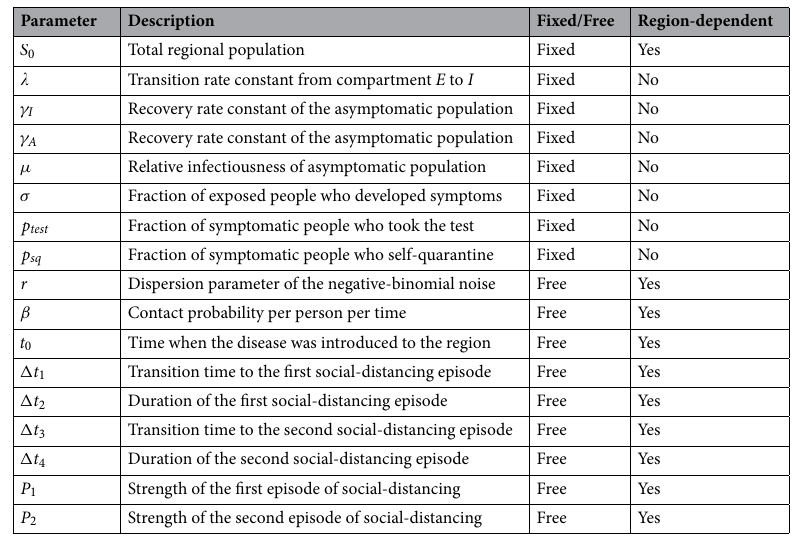
Table 1. List of data-driven model parameters.